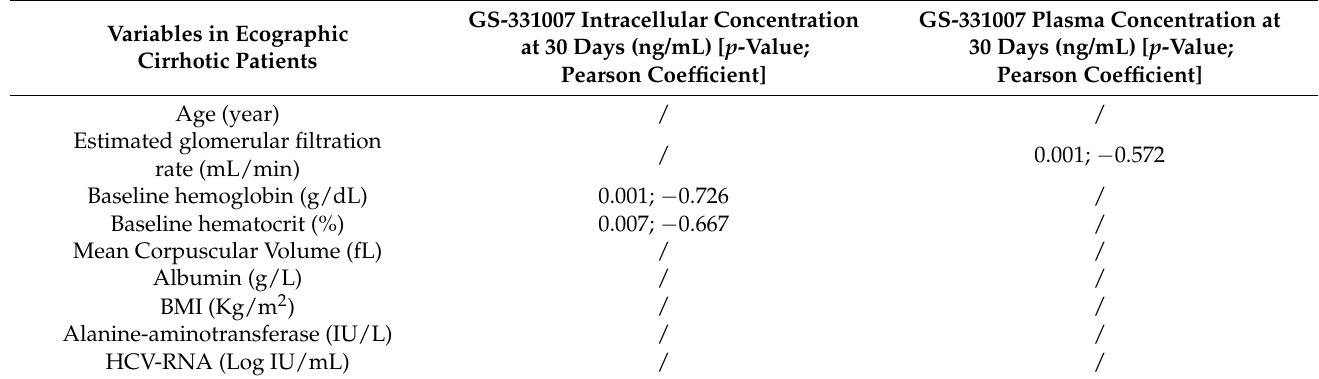
Table 3. Associations of GS-331007 IC and plasma levels with demographic and hematochemical parameters in ecographic cirrhotic patients.